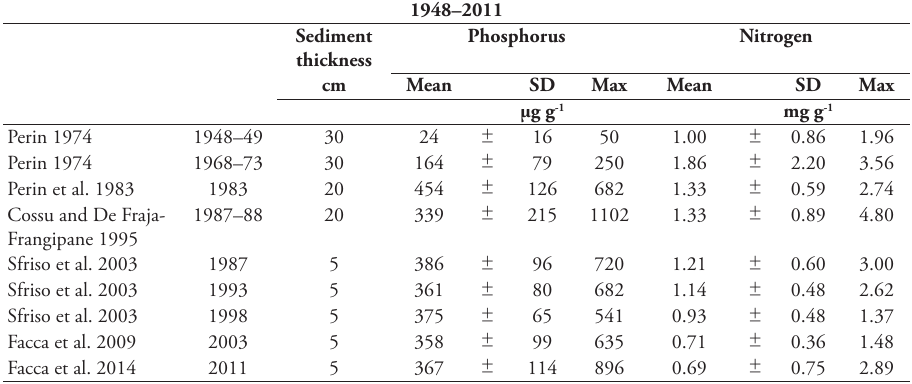
Table 1. Nitrogen and phosphorus changes in surface sediment top layer (5 cm) in the whole lagoon.